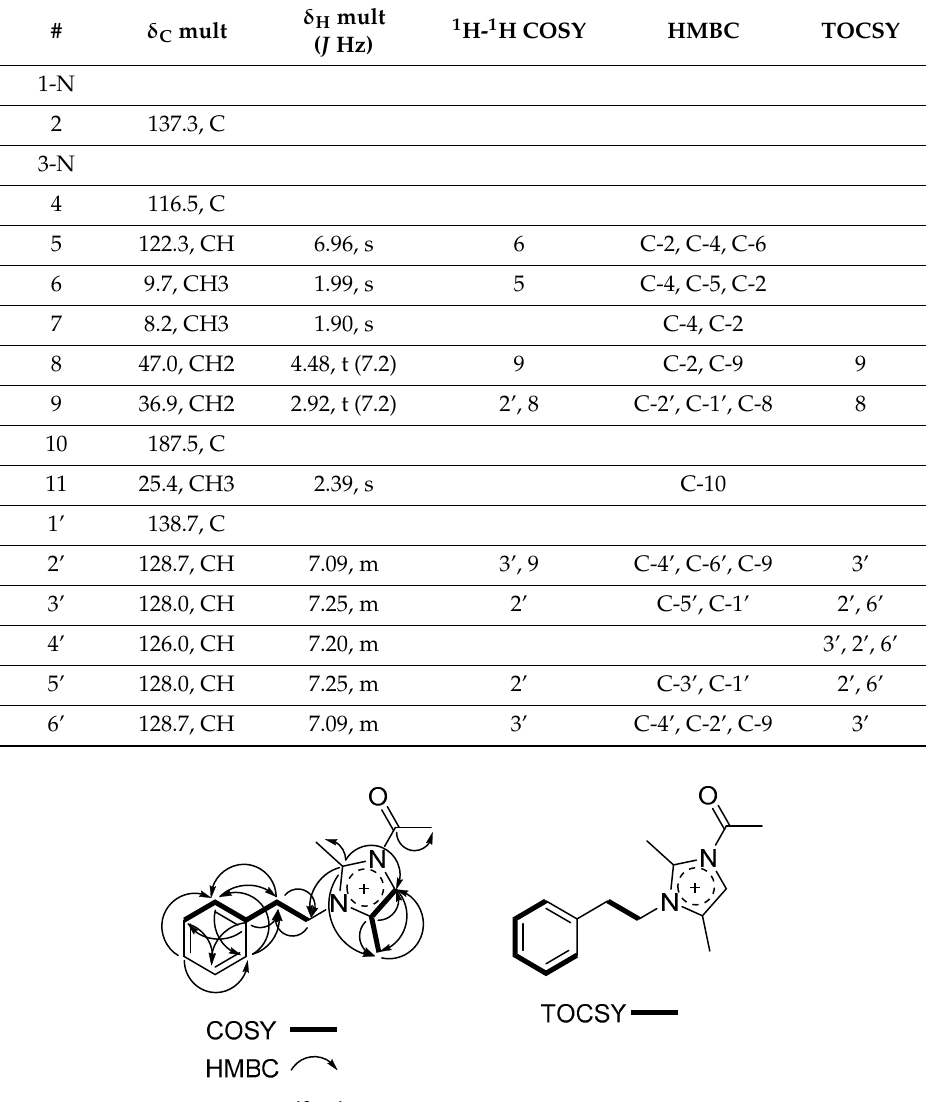
Figure 2. Key COSY (bold lines), 13 C- 1 H HMBC (single arrows), and TOCSY (bold lines) correlations for compound 1 .